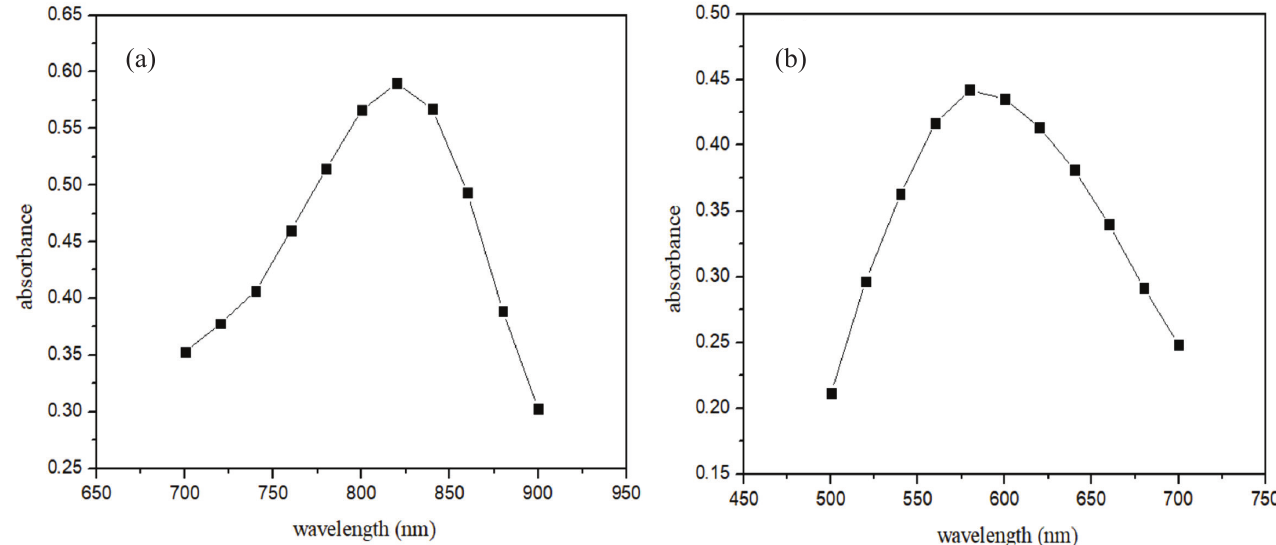
Fig. 4 – Maximum wavelength plots for As(III) (a) and Cu(II) (b)